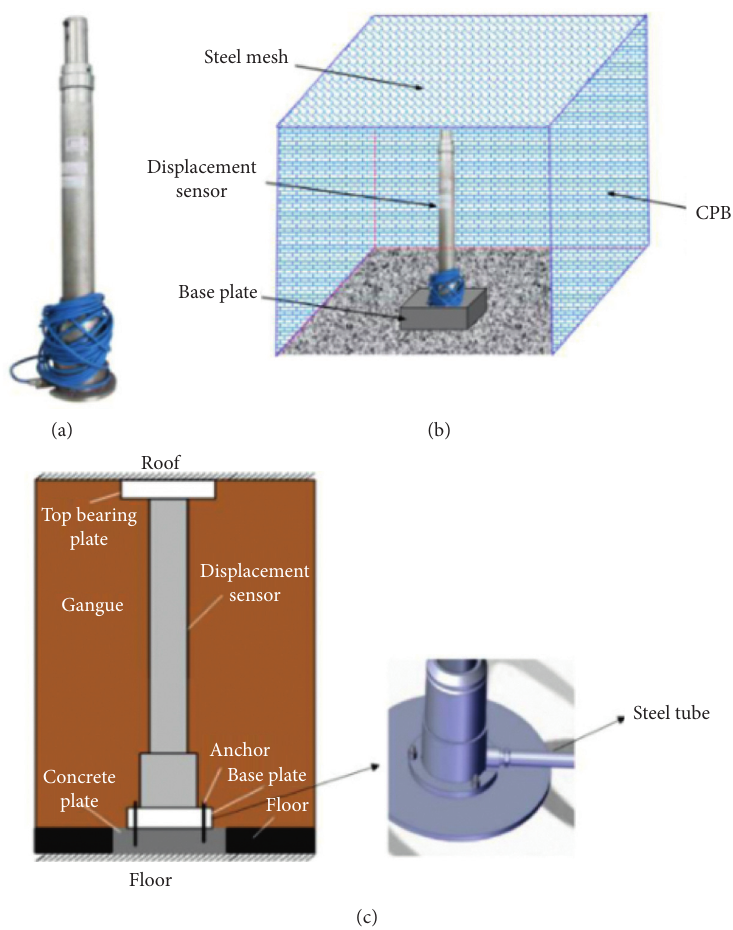
Figure 10: (a) Column-type displacement sensor, (b) installation of displacement sensor, and (c) components of the installed column-type displacement